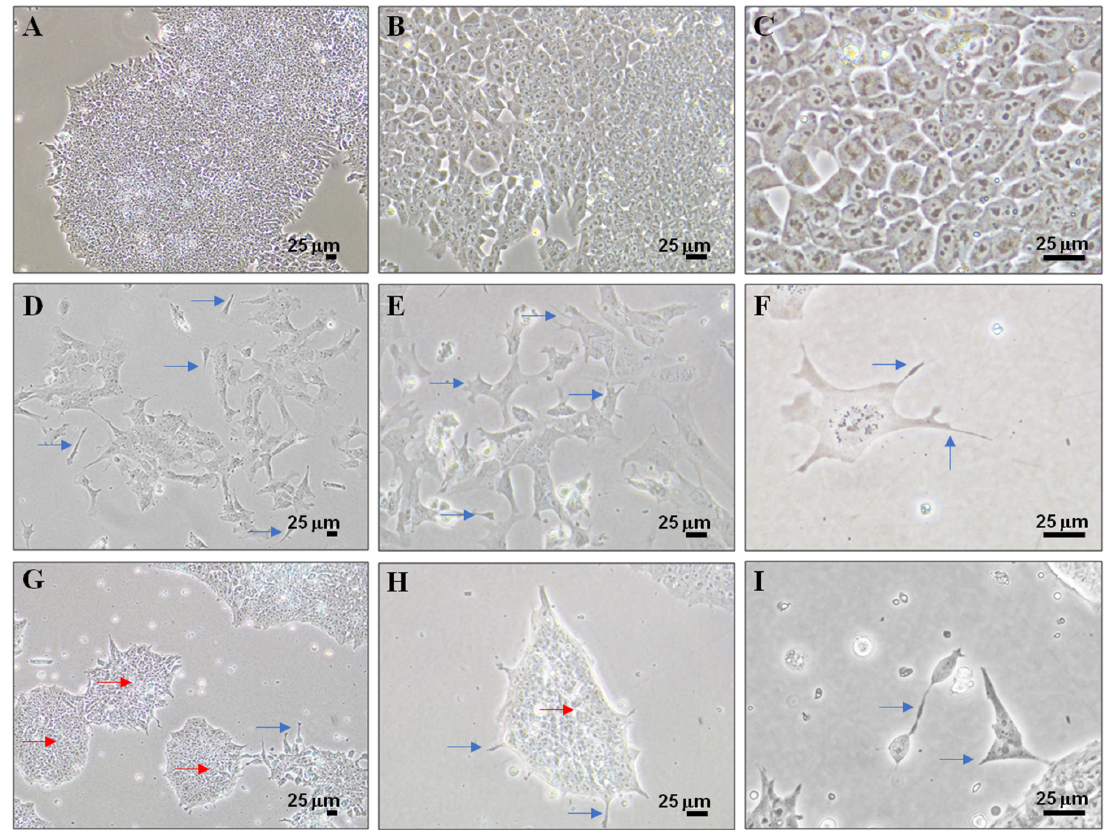
Figure 2. Phase contrast microscopy of undifferentiated P19 stem cells ( A – C ) and cells treated with 1 μ M retinoid acid ( D – F ) or 50 μ M PK 11195 ( G – I ) during 4 days of culture. Blue arrows show cell extensions; Red arrows show spherical growing colonies. Scale bar at the bottom right, 25 μ M. ( A ), ( D ), ( G ) were taken at 100× magnification; ( B ), ( E ), and ( H ) were taken at 20× magnification; ( C ), ( F ), and ( I ) were taken at 400× magnification.